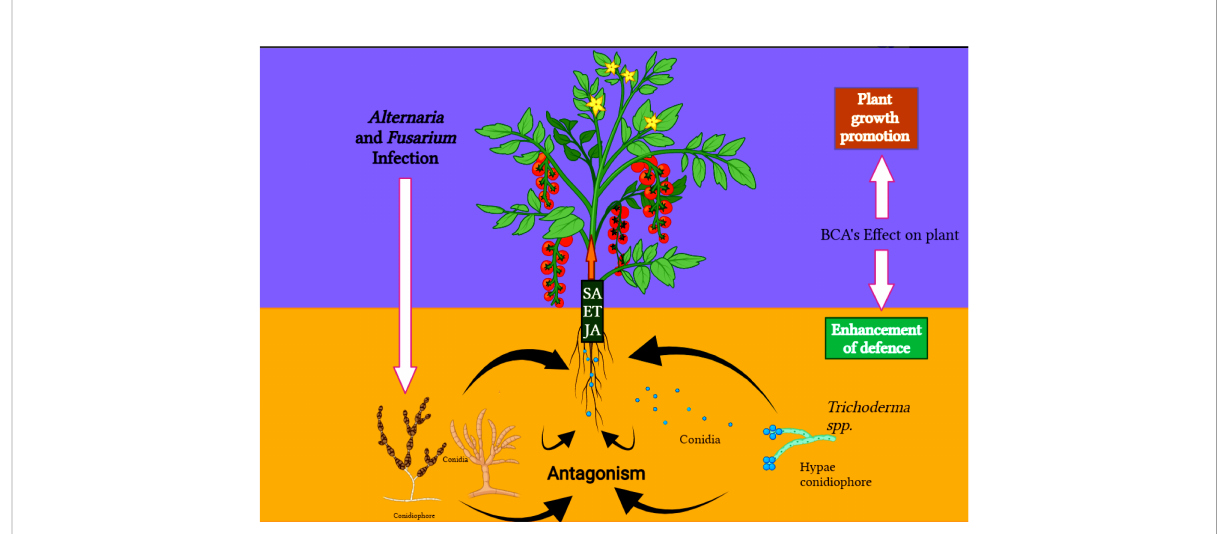
FIGURE 3 Plant-pathogen-antagonist tri-trophic interaction, how Trichoderma species can modulate the molecular signaling in the challenge between the Fusarium and Alternaria and the host